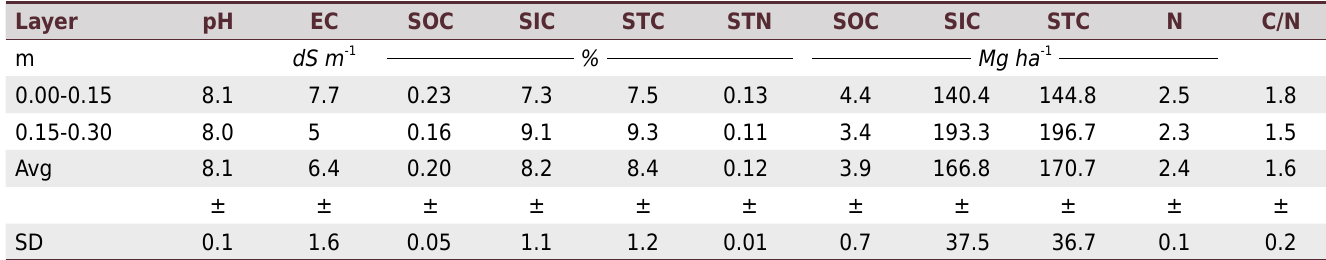
Table 1. Physico-chemical and chemical properties of soil samples from La Comarca Lagunera, Mexico Layer